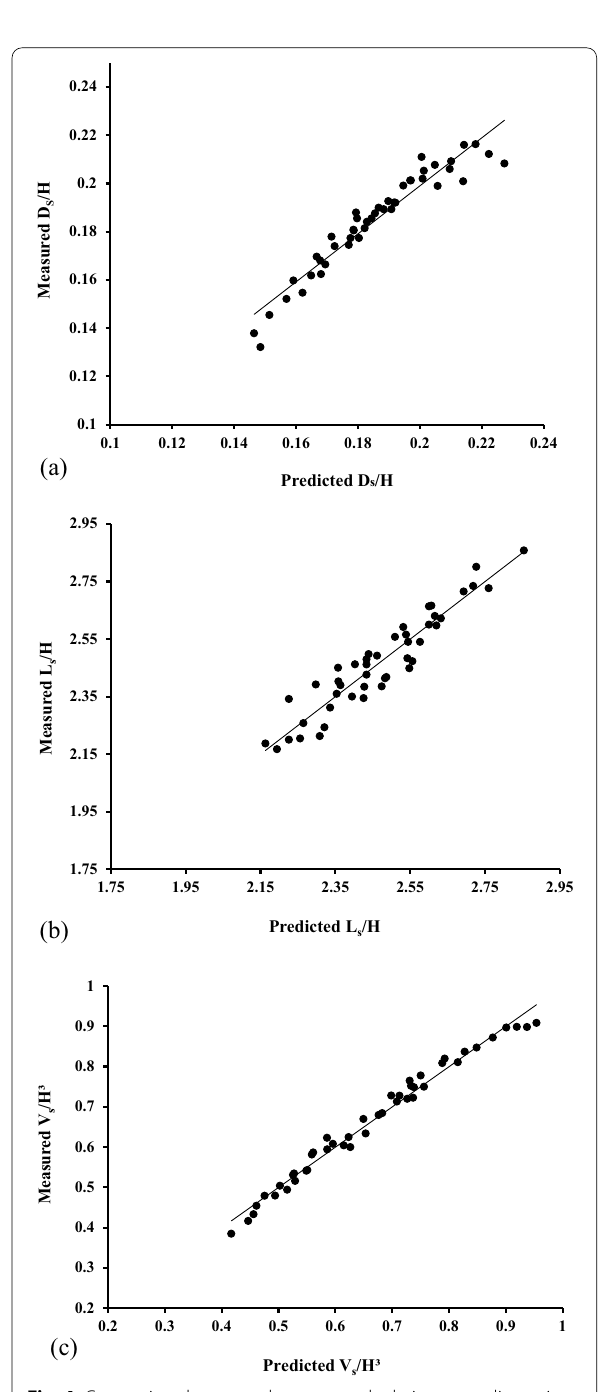
Fig. 4 Comparison between the measured relative scour dimension values and those predicted by a Eq. (3); b Eq. (4); and c Eq.